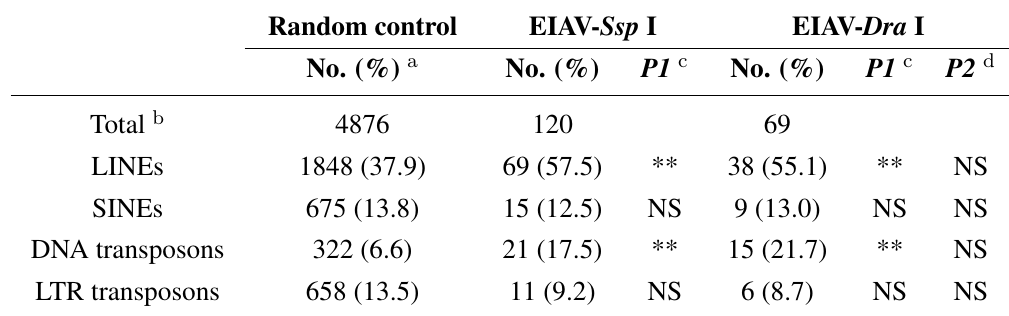
Table 3. Correlation between repetitive elements and EIAV integration sites in the horse